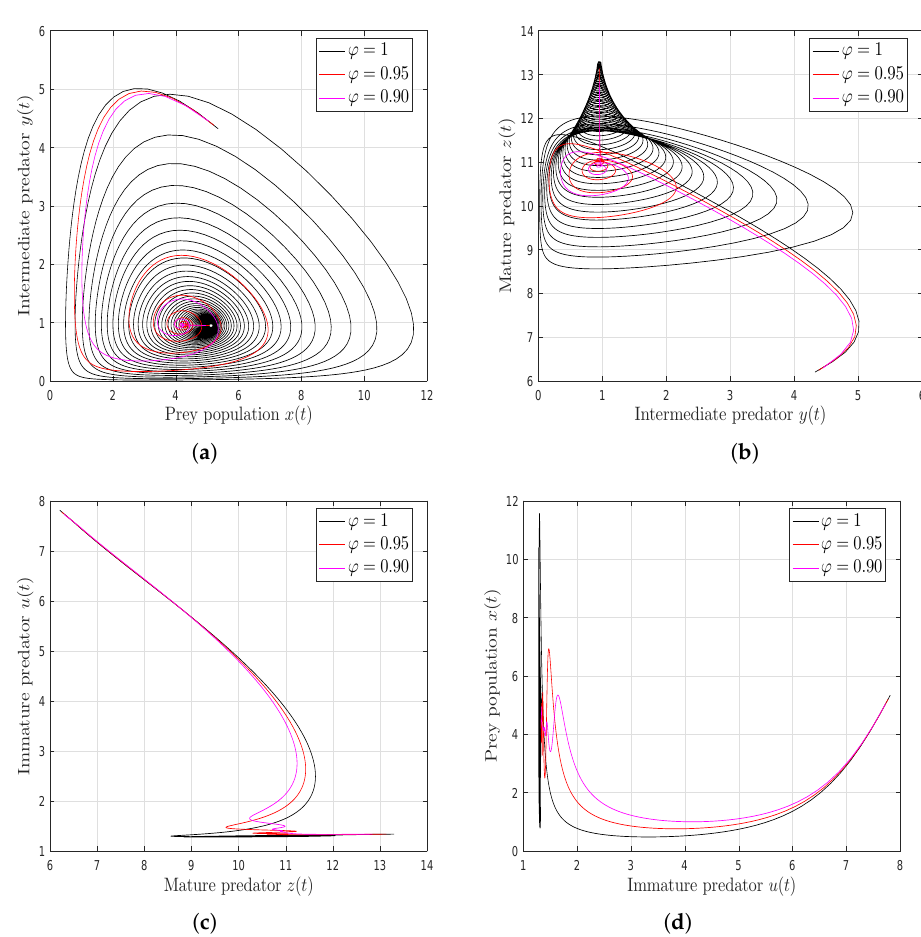
Figure 8. Two-dimensional chaotic phase plot for food web mathematical System (13) with general- ized Caputo fractional operator when ρ = 0.80.